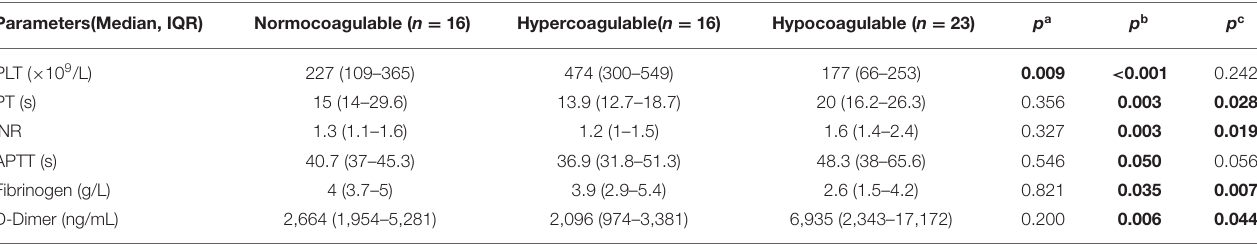
TABLE 2 | Performance of conventional parameters in the discrimination of coagulation status based on thromboelastometry. Parameters(Median, IQR) Normocoagulable ( n =